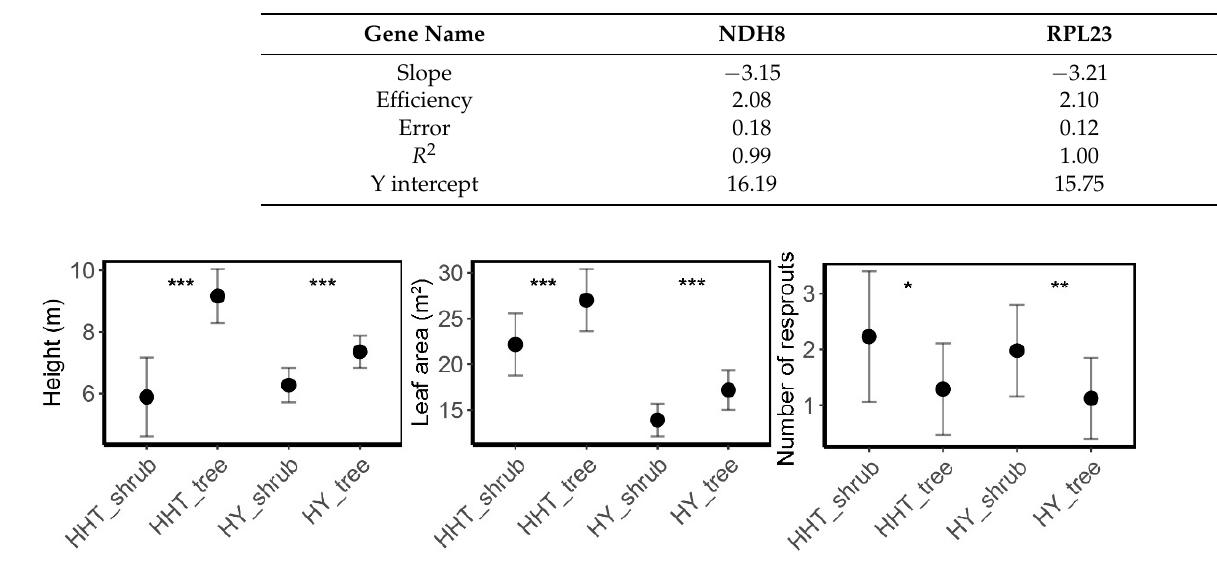
Figure A1. Tree architecture traits of the Quercus mongolica shrubs and trees in the HHT and XJ regions. The points show the mean value of the plots, while the vertical lines show the standard deviation. The stars show the results of Student’s t test: ***, p < 0.01; **, p < 0.05; *, and p < 0.1. For each plot, n = 20.